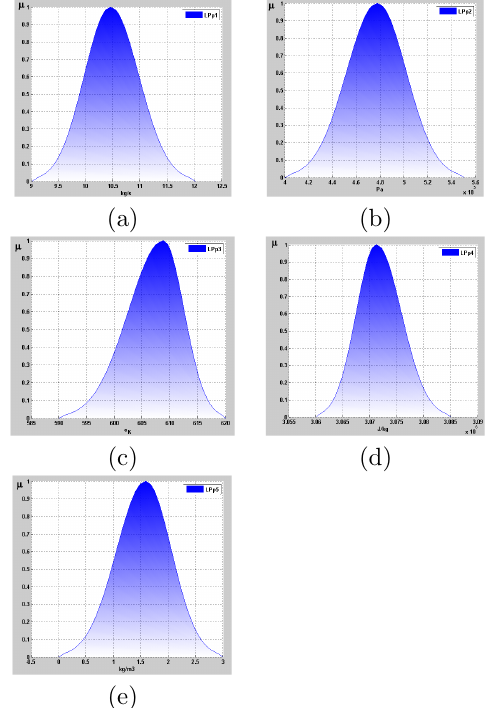
Figure 4. Fuzzy input parameters of low-pressure section of a steam turbine system (a) p 1 (Inlet steam flow from boiler superheat section), (b) p 2 (Inlet steam pressure), (c) p 3 (Inlet steam flow temperature), (d) p 4 (Inlet steam flow enthalpy) and (e) p 5 (Inlet steam flow